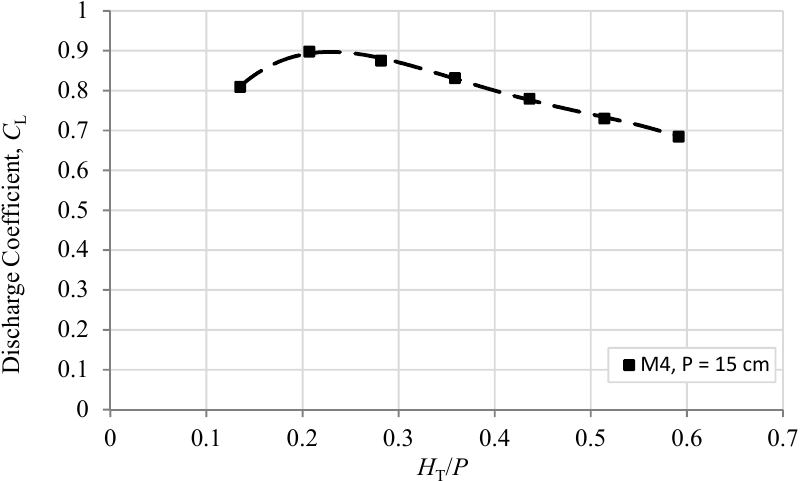
Figure 8. Variations in the discharge coefficient, C L , as a function of the H T /P ratio for the M4 model.